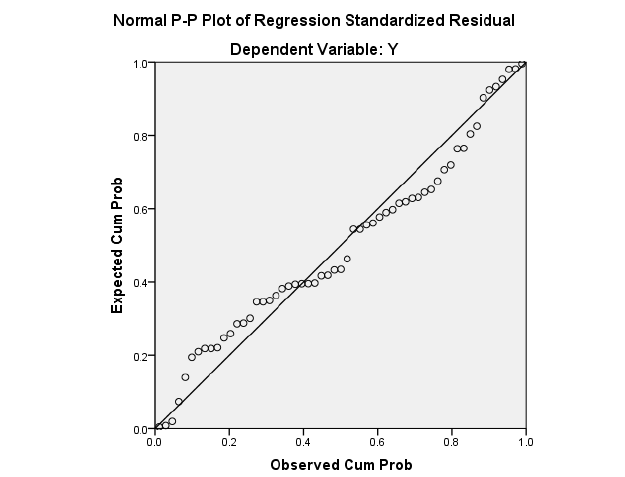
Gambar 3 Normal P-Plot Sumber: Pengolahan Data SPSS 2016